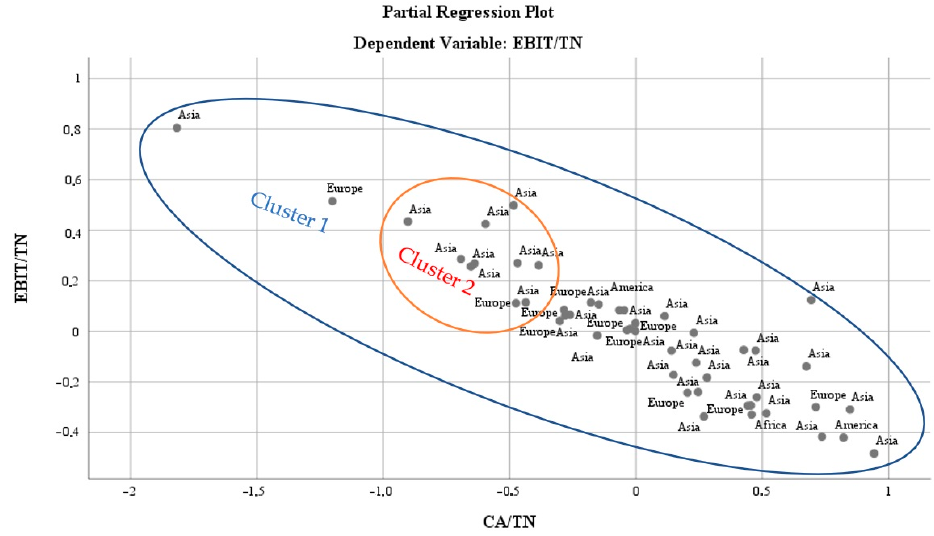
Figure 4. Distribution clusters of the value of the current asset utilisation efficiency regressor on the overall economic performance rate.